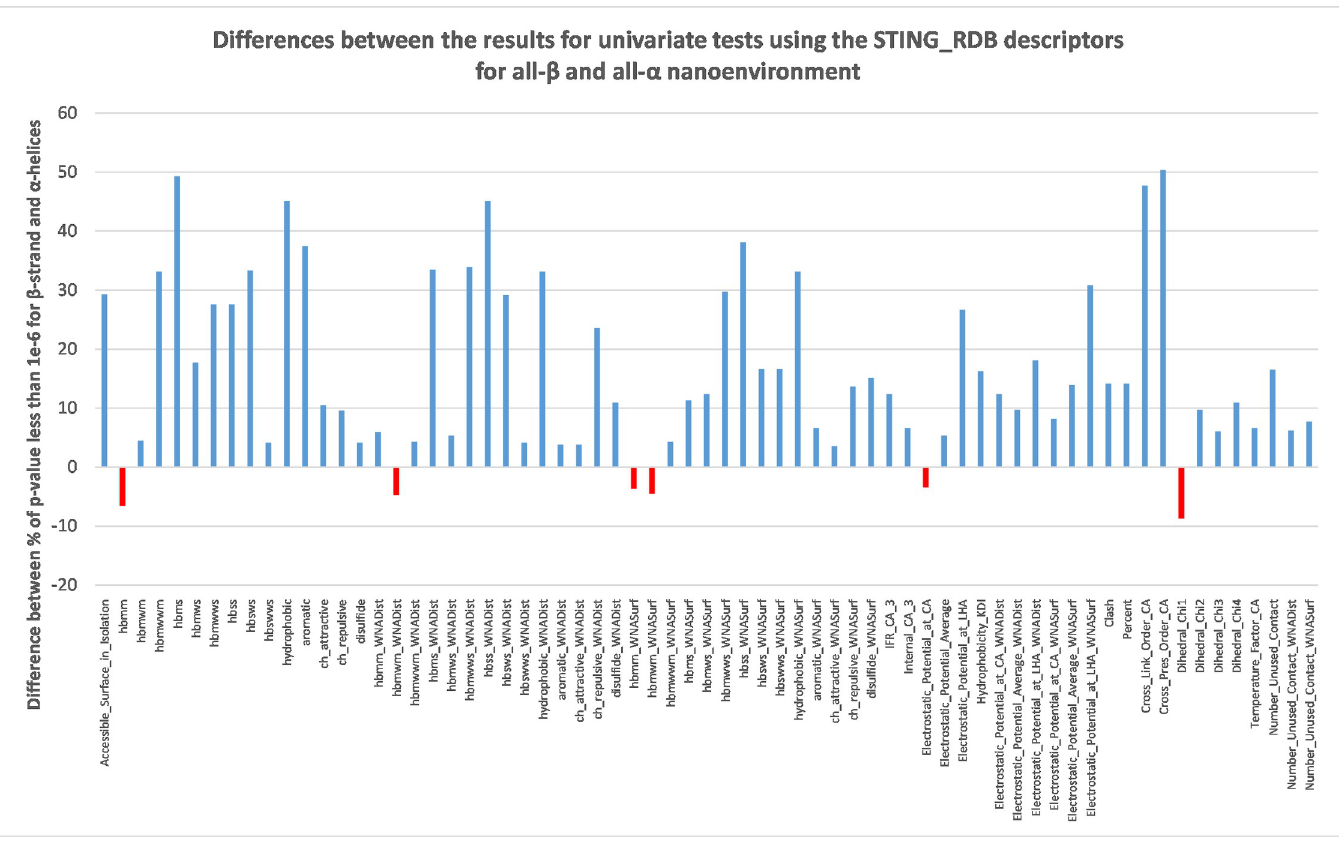
Fig 1. Differences observed in percentwise coverage for p-values being less than 1e-6 for univariate test results using the STING_RDB descriptors for beta sheets in all- β and alpha helices in all- α protein nanoenvironments.